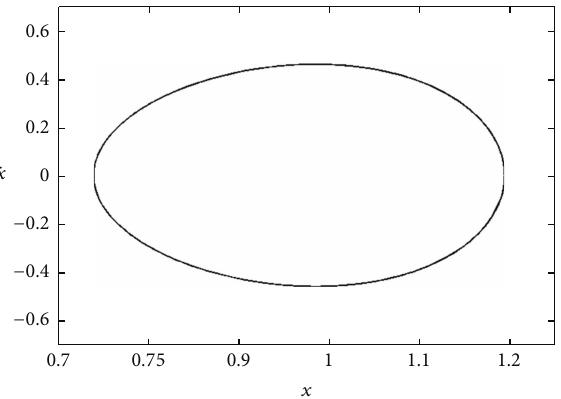
Figure 6: Limit cycle of (59) with 𝐹 = 3